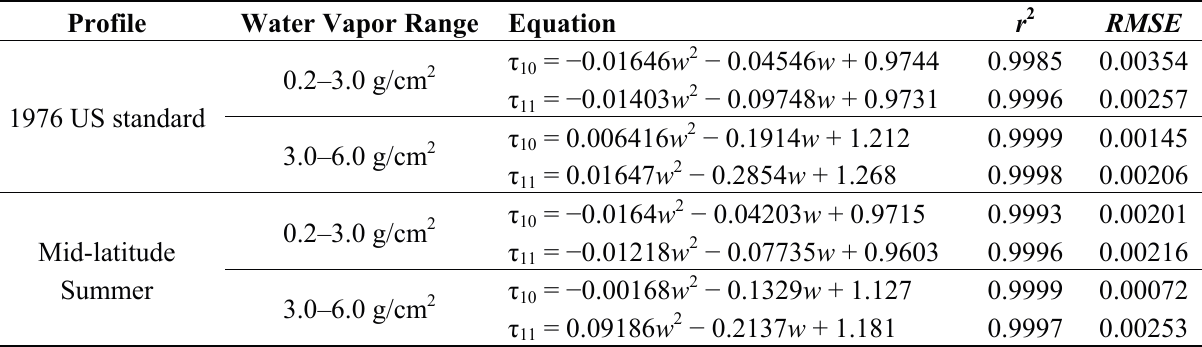
Table 2. Relationship between atmospheric transmittance ( τ ) and water vapor content ( w ) with 1976 US standard and Mid-latitude Summer atmospheric